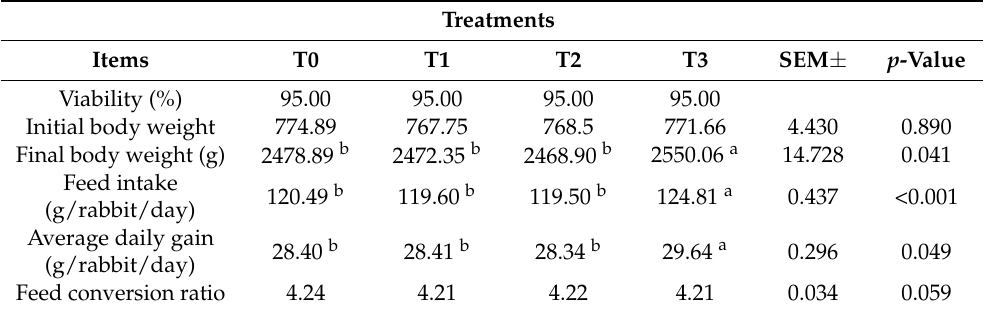
Table 2. Effect of A. tequilana stem powder on performance of rabbits (35–95 days